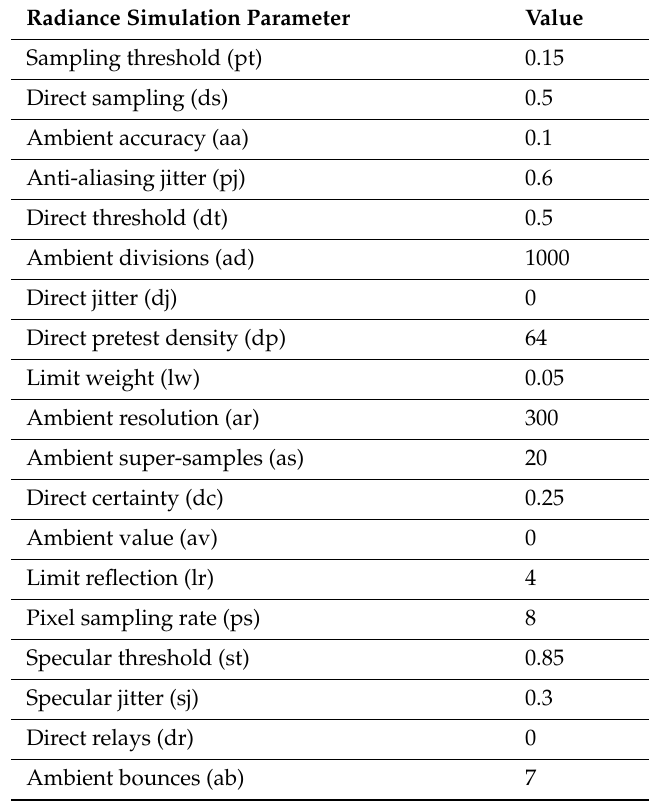
Table 8. Parameters for evaluation of sDA and